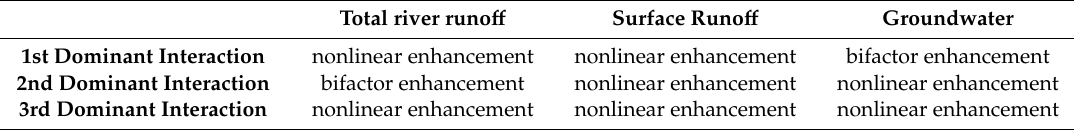
Table 7. Interaction modes of the factors on runo ff in the middle elevation plain region.